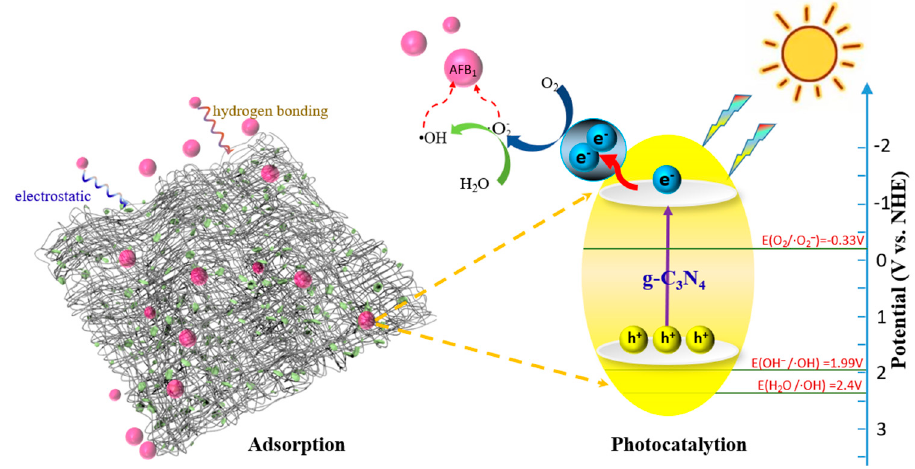
Figure 12. The adsorption and photocatalytic mechanism of removal/degradation of AFB 1 for the modified PCL-g-C 3 N 4 /CQDs electrospun membranes.